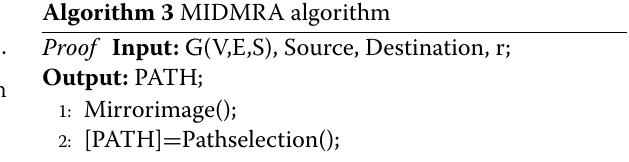
1. If the path causes ∞ distance, it would be deleted. In this case, reselected nodes must exist in this path, which is in conflict with the rule of disjoint paths route under single interface terminal environment, so this assumption is incorrect. 2. When new paths are generated, the parent path would be deleted. According to the principle of MIDMRA, parent paths should be included in new paths when it is deleted, unless all neighbor nodes of parent paths are not appropriate for selecting or there are no neighbor nodes. The prior scenario breaks other deleting rules, and the last one means that the path could not route to destination, both assumptions are unable to find out disjoint paths. 3. It is complicated in this case as there are a lot of comparisons between existing paths and a new path. Suppose there is tail node i in new path k, which is a reselected node between path k and another existing path b in PATH. Then, path b should be compared with path k from S to